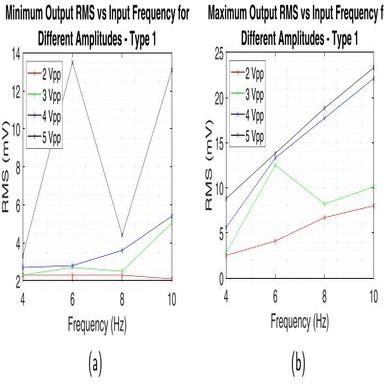
Moving coil (Type 1) results for maximum magnet internal travel of 30 mm: a) min RMS; b) max RMS.